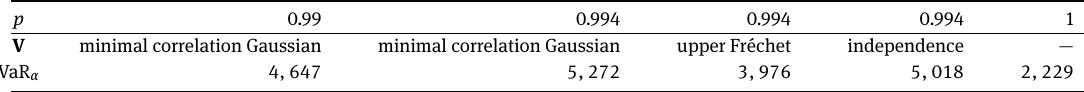
Table 8: Survey over VaR-estimates under different copula models with lognormal margins, in MMU. p 0.99 minimal correlation